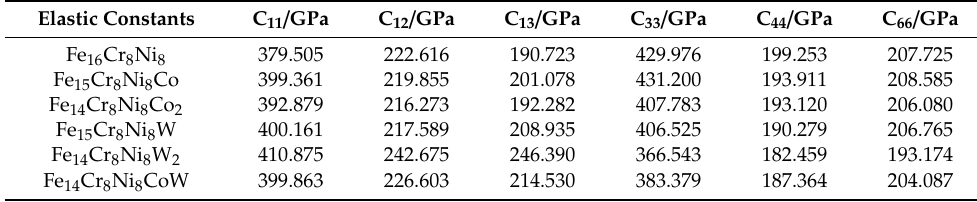
Table 2. Calculated single-crystal elastic constants for di ff erent